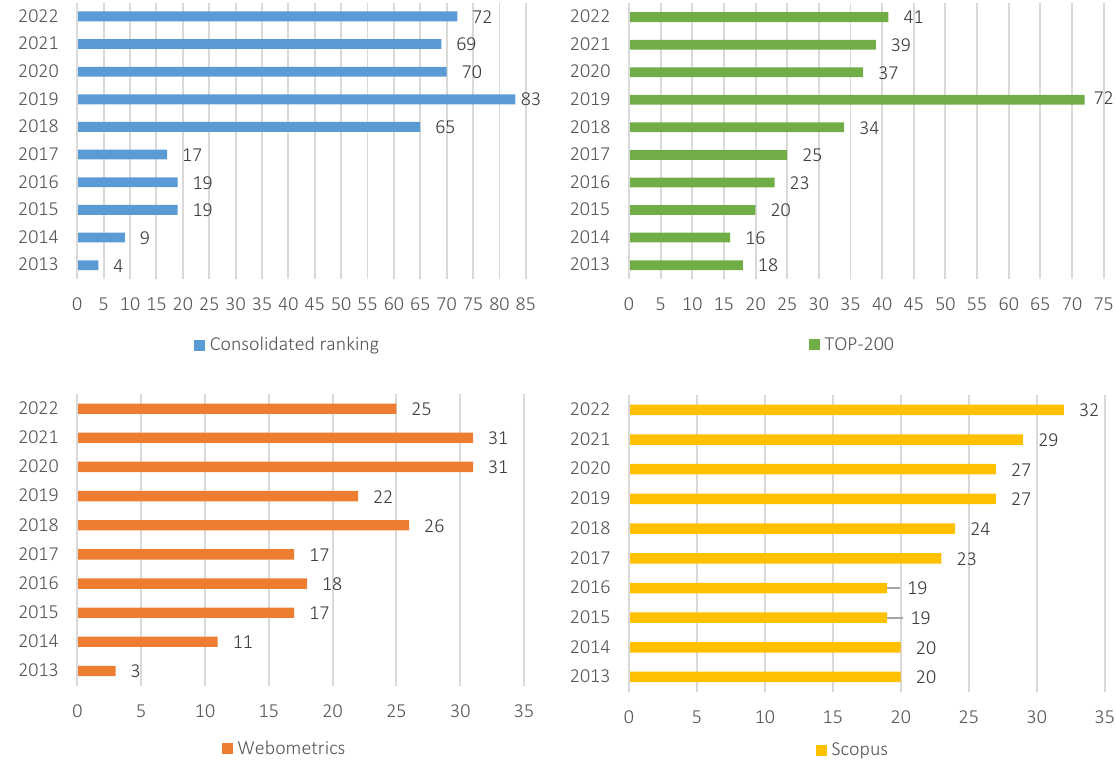
Figure 2. Dynamics of Donetsk National Technical University in all-Ukrainian and